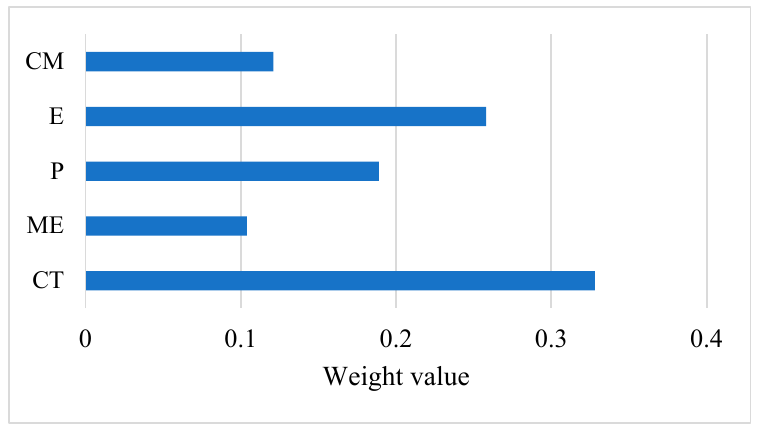
Figure 3. The weight values of the secondary risk indicators.